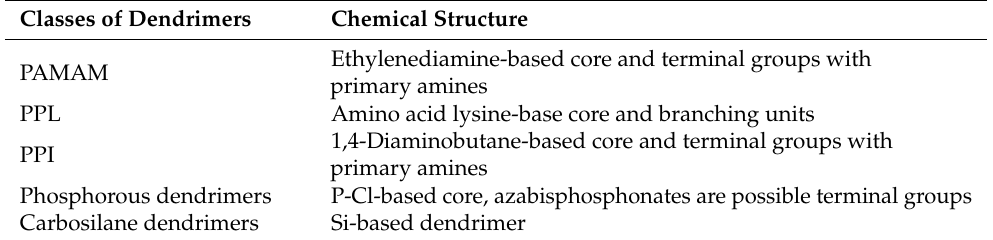
Table 1. Summary of different classes of dendrimers depicted in above